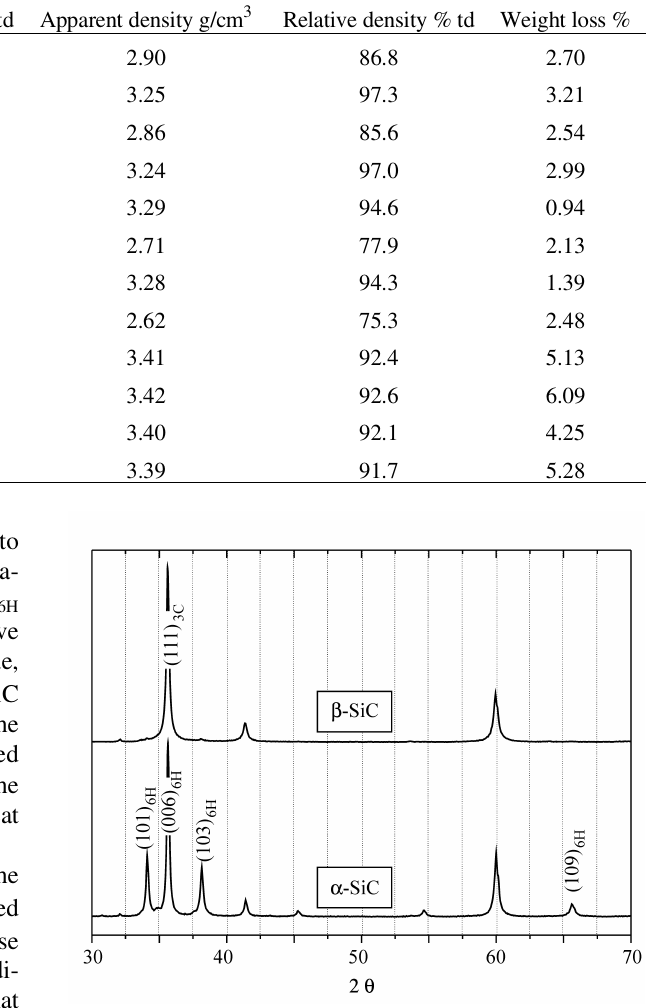
Figure 8. X-ray diffractograms of α -SiC and β -SiC powders (standards).